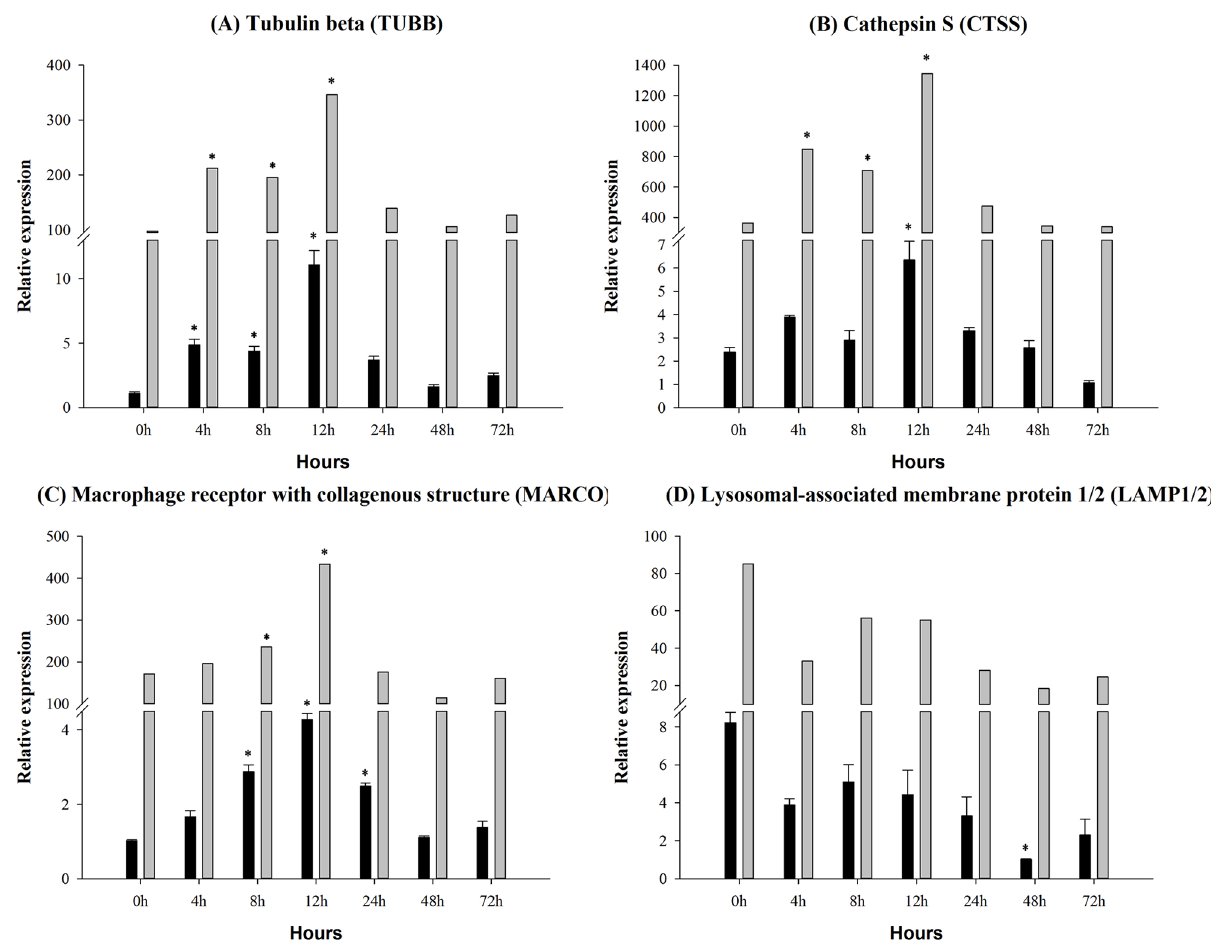
Fig 7. Phagosome-related pathway gene expression in control and experimental group intra-peritoneal injection with 2.7×10 7 CFU/mL (100 μ L/fish) Aeromonas hydrophila , as determined by qRT-PCR. (A) TUBB, (B) CTSS, (C) MARCO, (D) LAMP1/2. The black and the gray column represent selected gene and sequencing data, respectively. Values are presented as the mean ± SD (n = 6). The expression levels with * indicate significant differences with control group (p < 0.05).